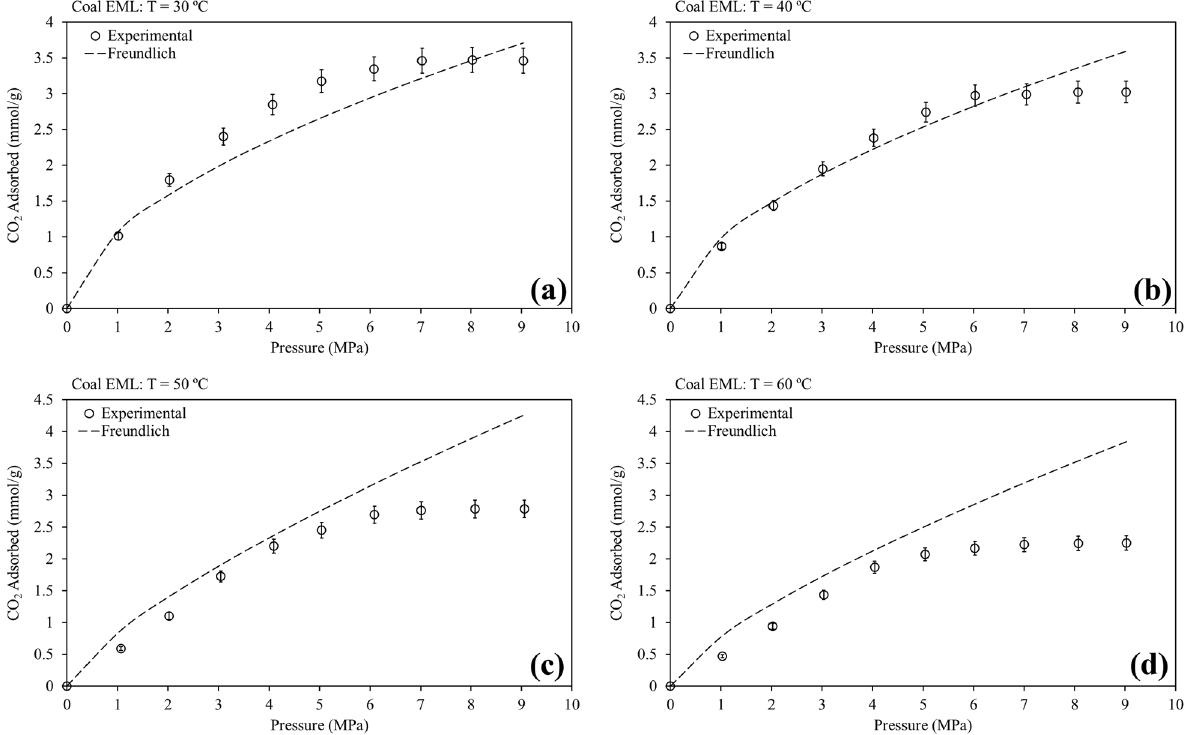
Fig. 3 Freundlich isotherm model fit for pure CO 2 sorption on Coal EML at a 30 ºC, b 40 ºC, c 50 ºC, and d 60